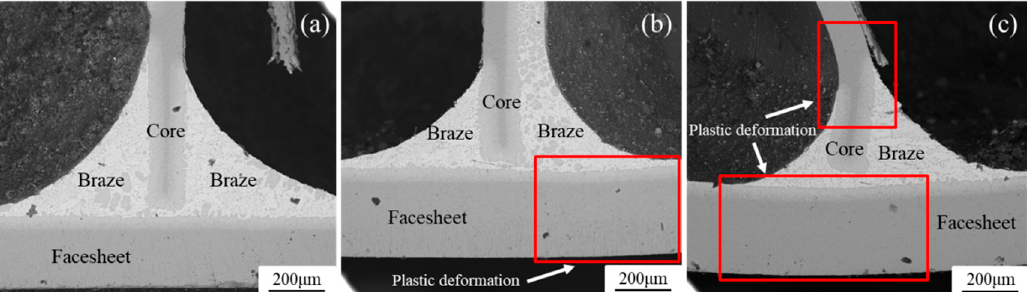
Figure 13. Microstructure of the brazed joint in the samples subjected to bending experiments at ( a ) 160 °C, ( b ) 300 °C, and ( c ) 440